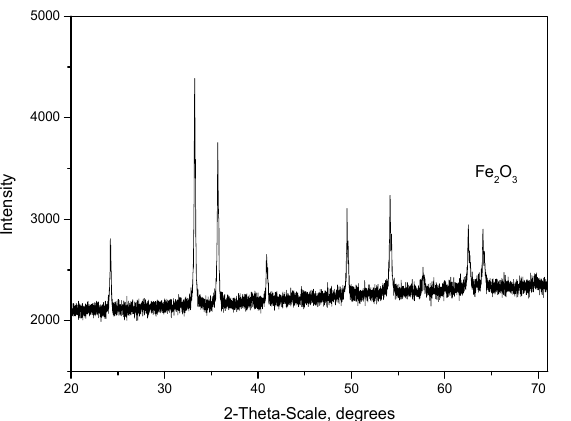
Figure 11. XRD pattern of the residue by leaching with 1.0 M HCl in EG. Operation conditions: pulp density = 50 g/L, T = 25 °C, time = 120 min, stirring speed = 200rpm.